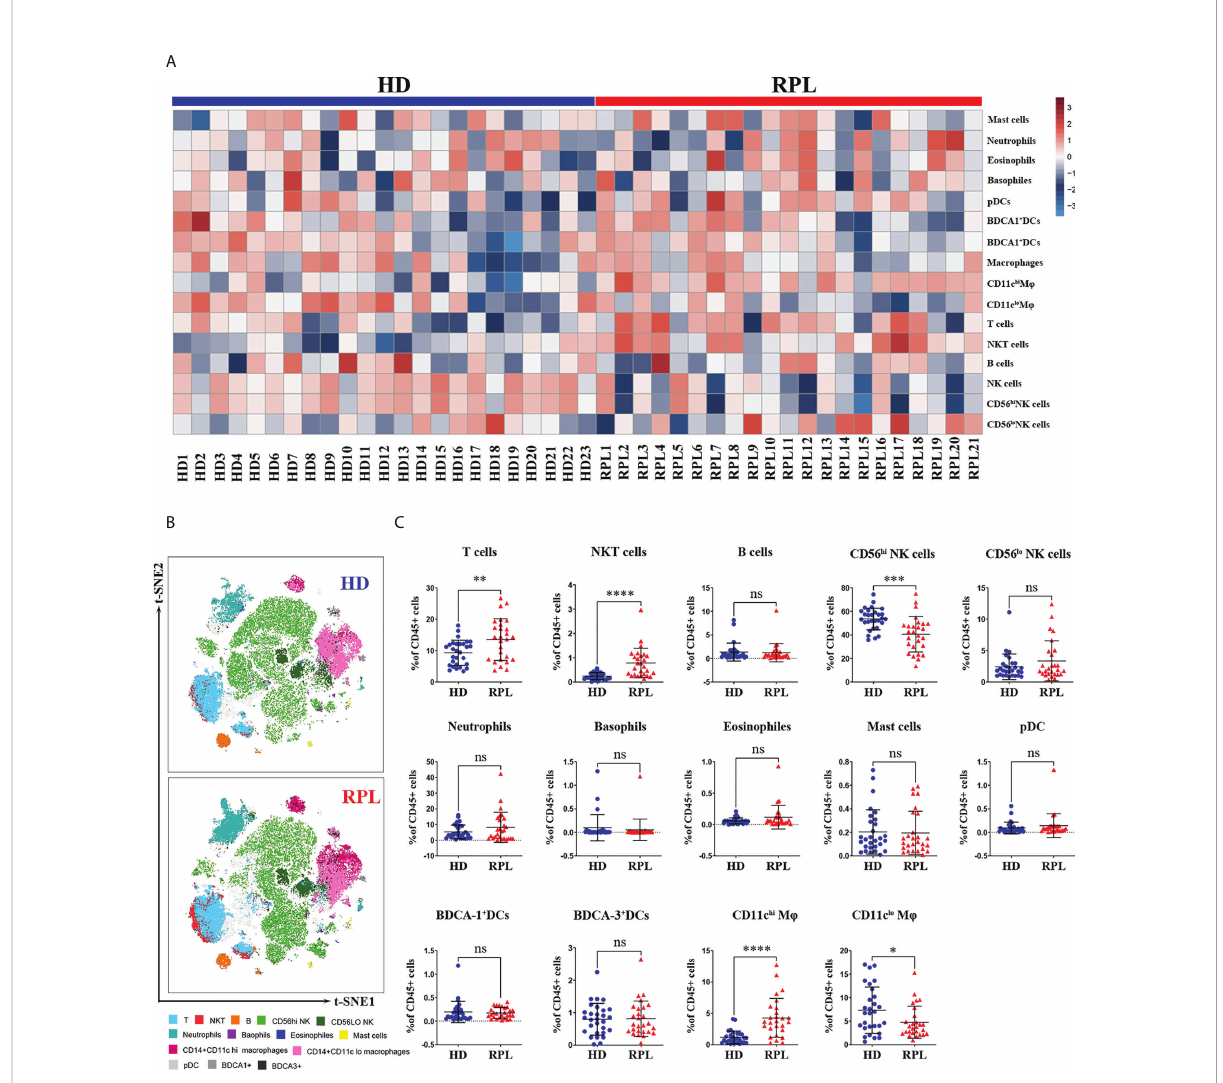
FIGURE 4 Global changes in decidual immune cell pro fi les. (A) Heatmap representation presenting the patient-to-patient variability of the log odds ratio derived from the proportion of CD45 + cells. (B) Representative tSNE plots of clustered CD45 + decidual immune cells were shown changes in RPL patients and HDs. (C) Regulated decidual immune cell populations differentially abundant between RPL patients and HDs identi fi ed by fl ow cytometry. p<0.05 (*), p<0.01 (**), p<0.001 (***), p<0.001 (****) and ns, no signi fi